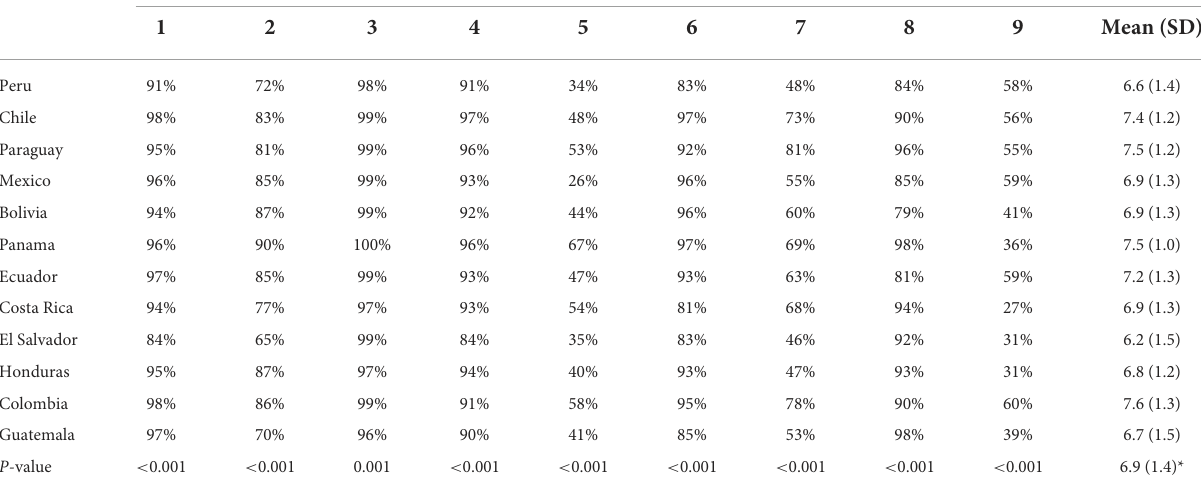
TABLE 2 Percentage of correct answers by each one of the nine questions of basic knowledge of COVID-19 in 12 countries in Latin America.